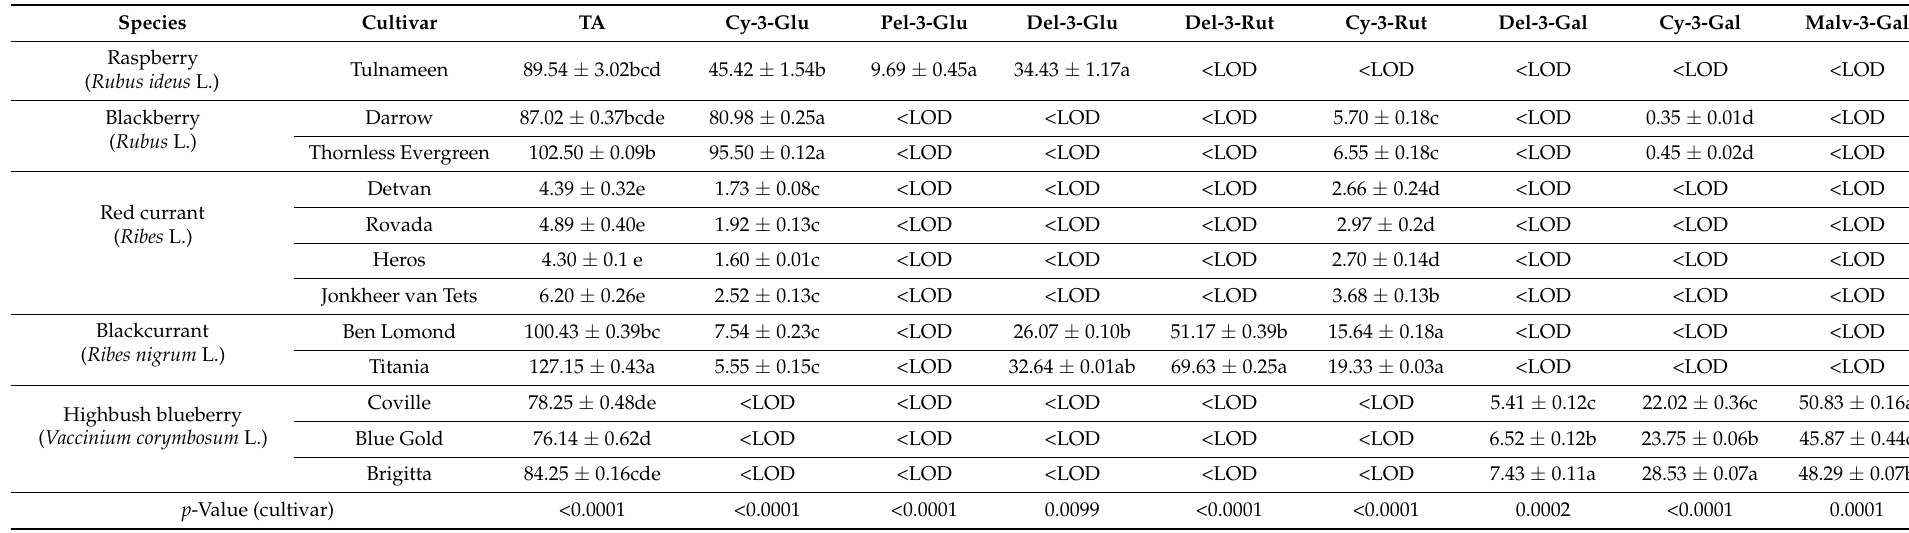
Table 3. The content of individual anthocyanins in different cultivars of berry fruits (in mg 100 g − 1 f.w.). Mean value ± SE. Species Raspberry ( Rubus ideus L.)